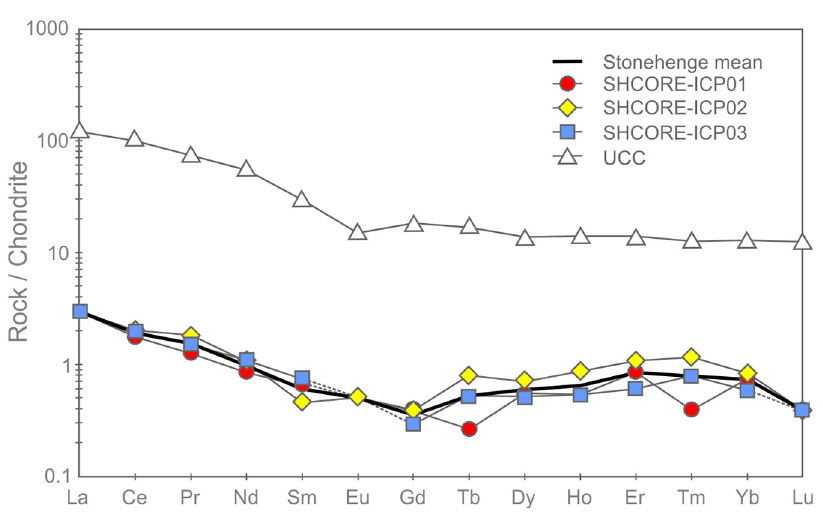
Fig 19. Chondrite-normalised REE diagram for the three subsamples from section 2–3 of the Phillips’ Core from Stonehenge (SH) showing the Upper Continental Crust (UCC) for comparison [42]. Concentrations below detection limit are plotted at detection limit and are signified by dashed lines [normalisation factors from